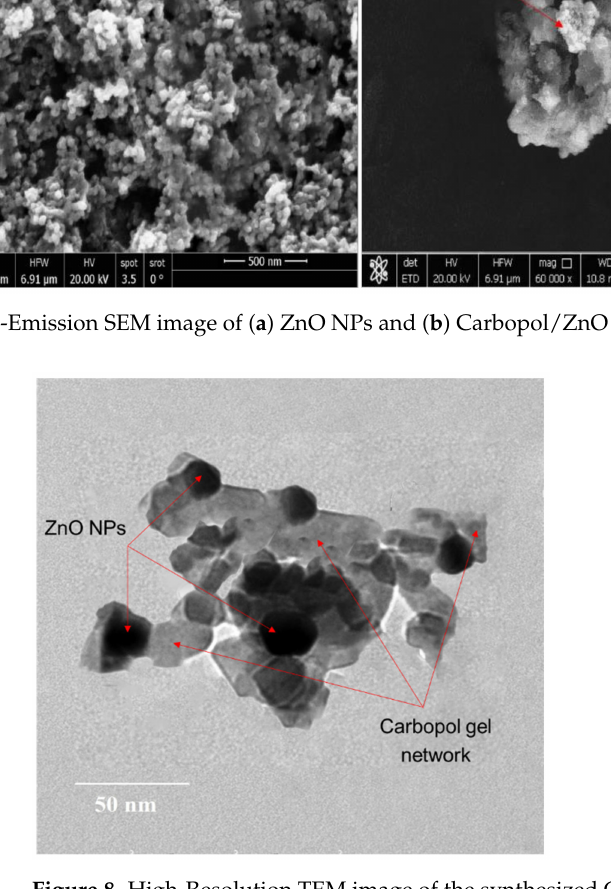
Figure 8. High-Resolution TEM image of the synthesized Carbopol/ZnO hybrid nanoparticles